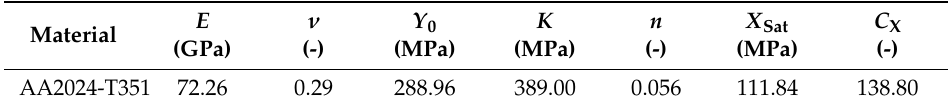
Table 1. Elastic properties of 2024-T351 aluminum alloy and parameters obtained for the Swift isotropic hardening law combined with the Armstrong–Frederick kinematic hardening